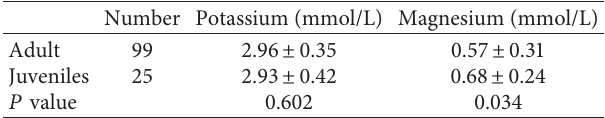
Table 4: Comparison of serum potassium and magnesium levels in the adult and juvenile groups ( x ± s ).